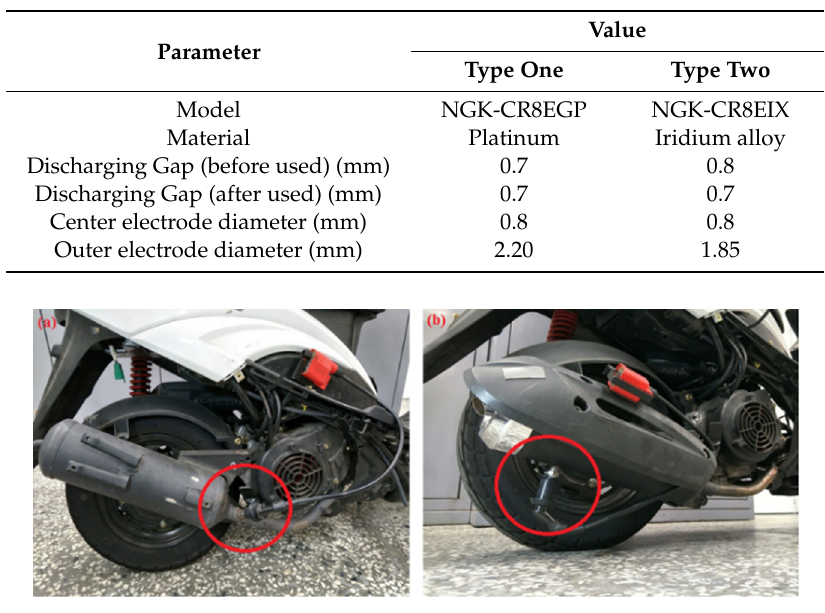
Figure 1. Schematic of this experiment and setup location. Table 3. The types of NTP reactor.